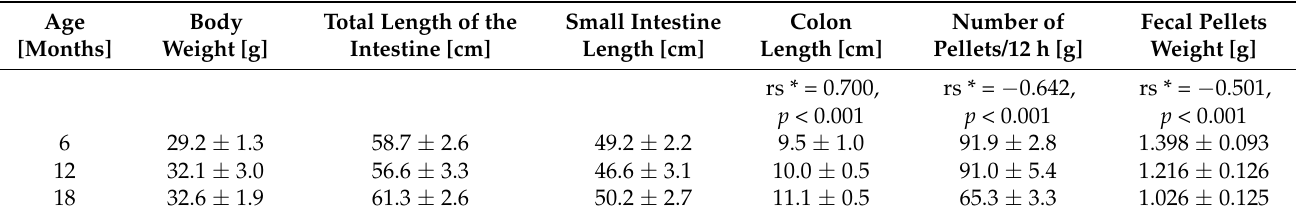
Table 1. The comparison of body weight, length of the intestines, the number and weight of the fecal pellets excreted overnight between 6-, 12- and 18-m.o. mice. Data are mean ± SEM. n = 7–9. rs * denotes Spearman’s correlation